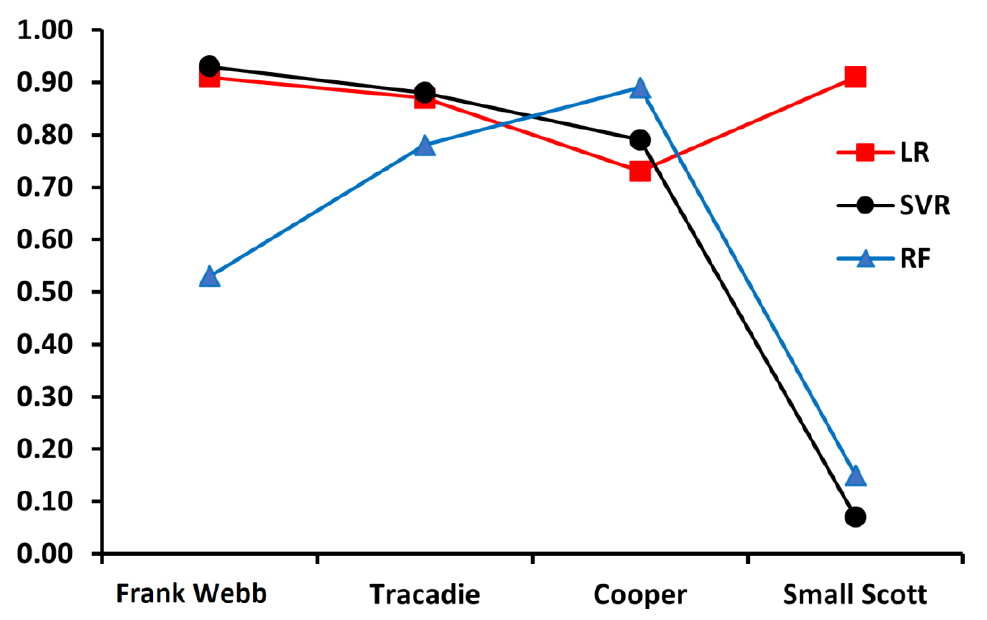
Figure 4. Comparison of machine learning algorithms within selected fields.